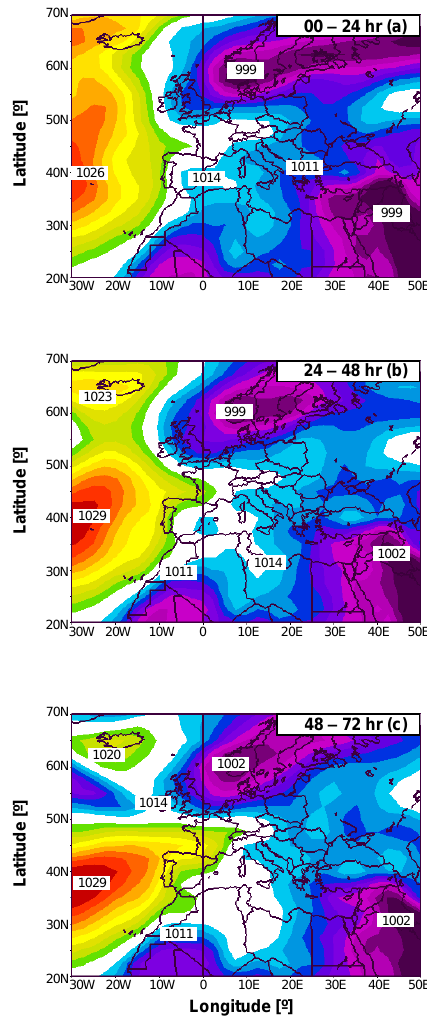
Figure 3. Mean synoptic situation from the NCEP/NCAR Reanal- ysis project at (a) 00–24, (b) 24–48 and (f) 48–72h after the “GO”. Purple and red colors represent low and high pressures,